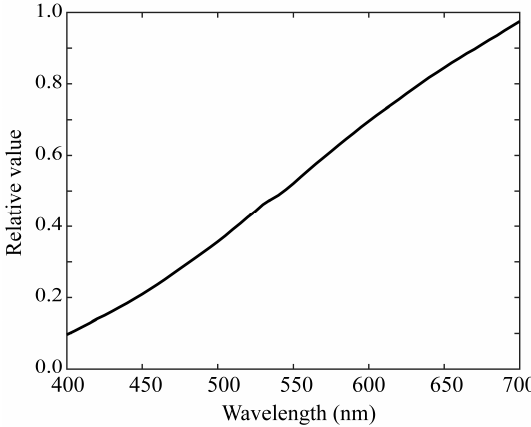
Figure 10. Color checkers used for reflectance estimation validation. ( a ) Imaging targets consisting of 24 color checkers and the white reference standard (Spectralon). ( b ) Spectral reflectances of the 24 color checkers measured by the spectral colorimeter.